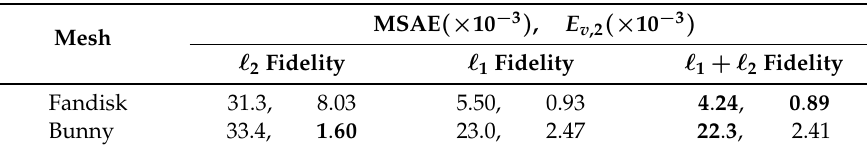
Table 3. Quantitative evaluation results of Figure 11.